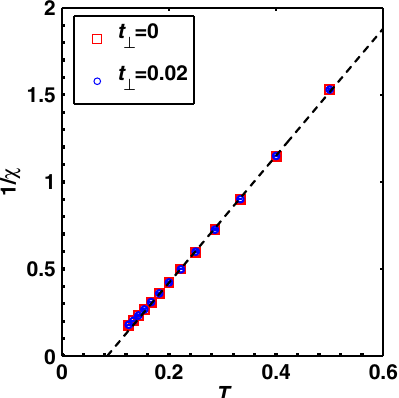
FIG. 8. The average of the fermion sign versus t ⊥ at different values of L . The parameters are V ¼ 0 , J ¼ 2 , n ¼ 1 , and β ¼ 6 .